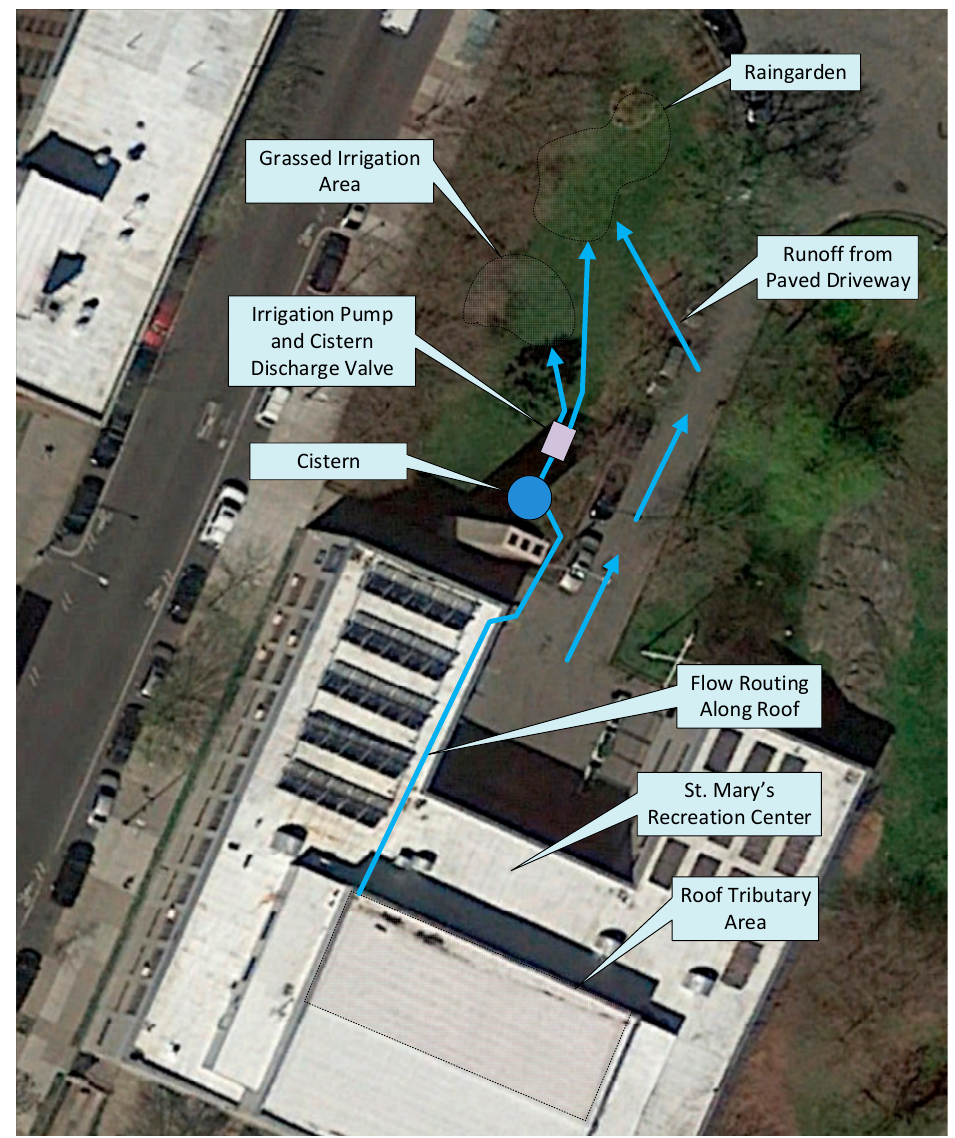
Figure 1. Schematic overview of system’s design ( image courtesy of Google Earth ).